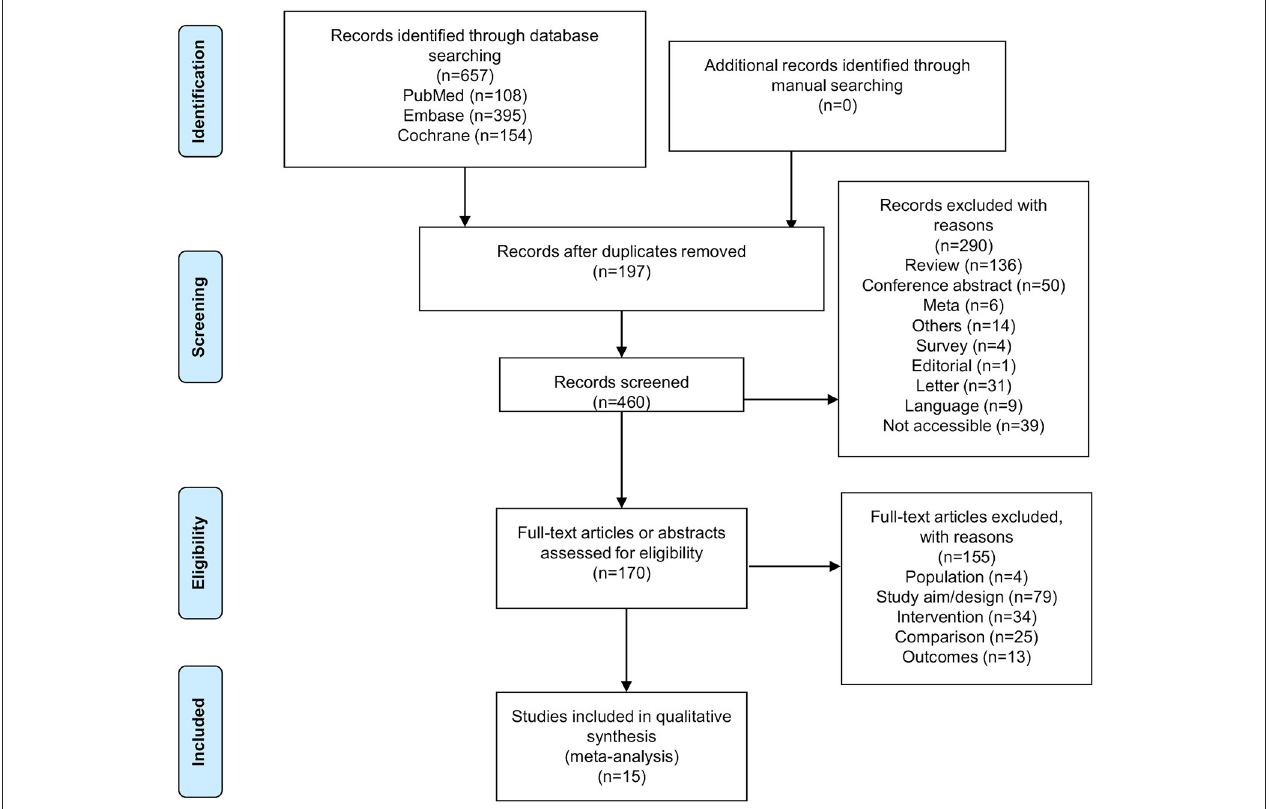
FIGURE 1 | Flow diagram of the study selection